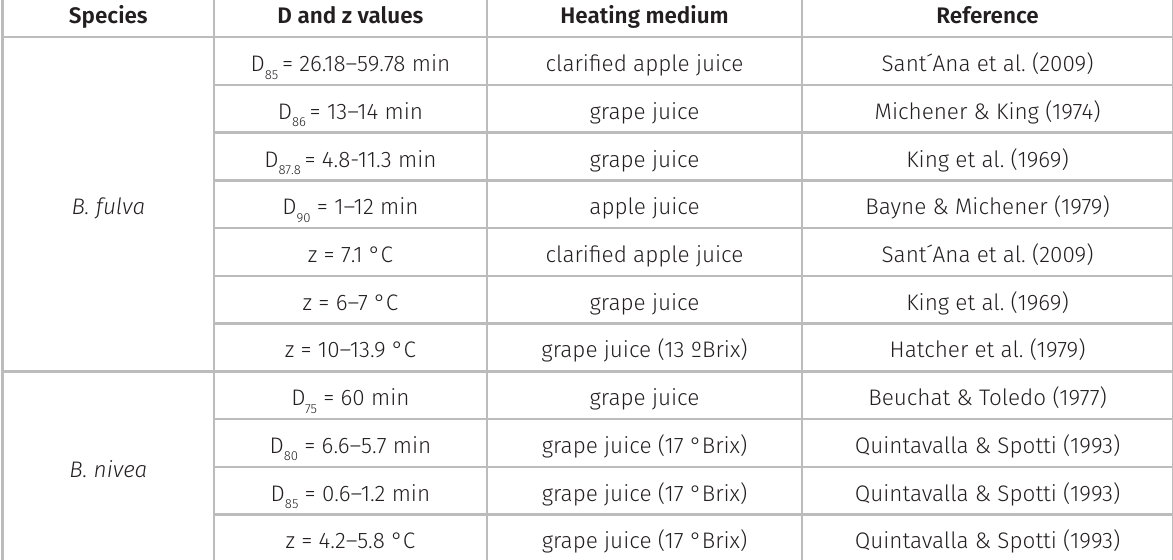
Table IV. D and z values for ascospores of the species Byssochlamys fulva and B. nivea (Nguyen 2012).